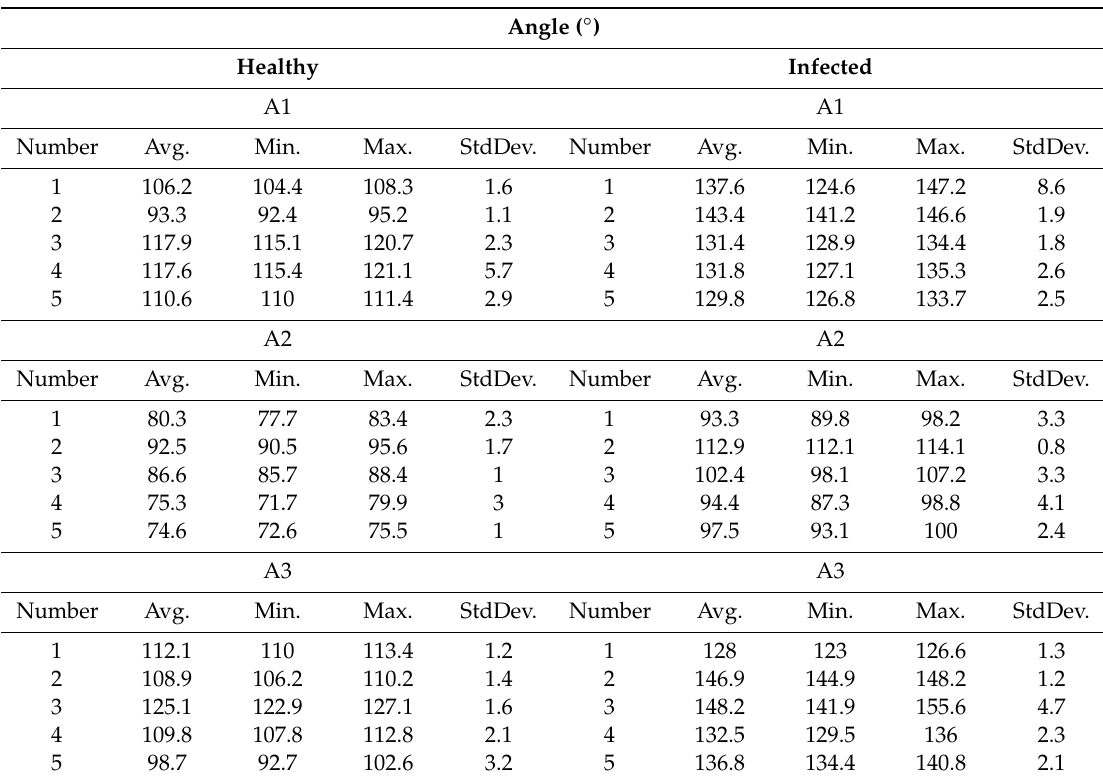
Table 3. Numerically evaluated average, minimum, and maximum three types of angular information compared between healthy and infected specimens with standard